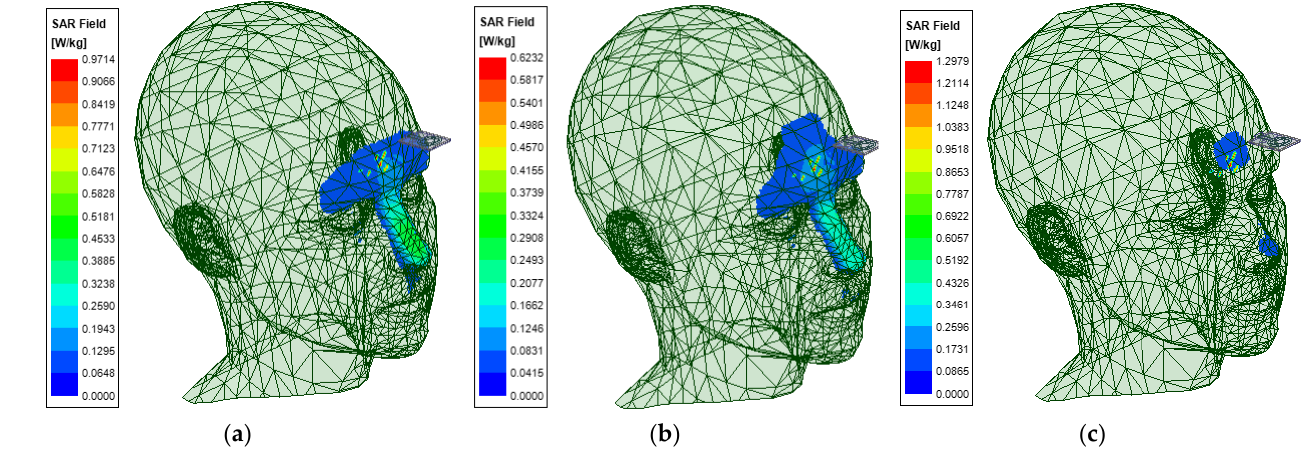
Figure 14. SAR analysis ( a ) 4 GHz ( b ) 6 GHz ( c ) 8 GHz.